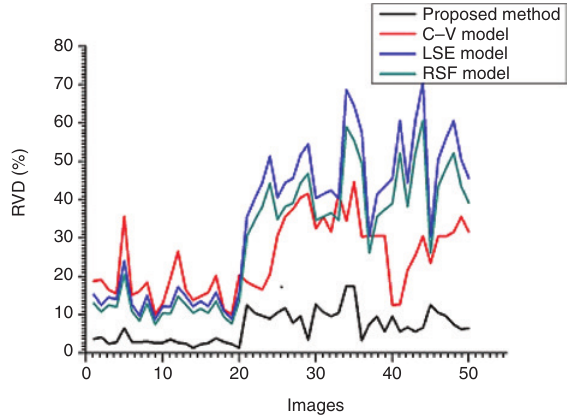
Figure 9: Comparison of Results Using RVD for CT Scan Images.